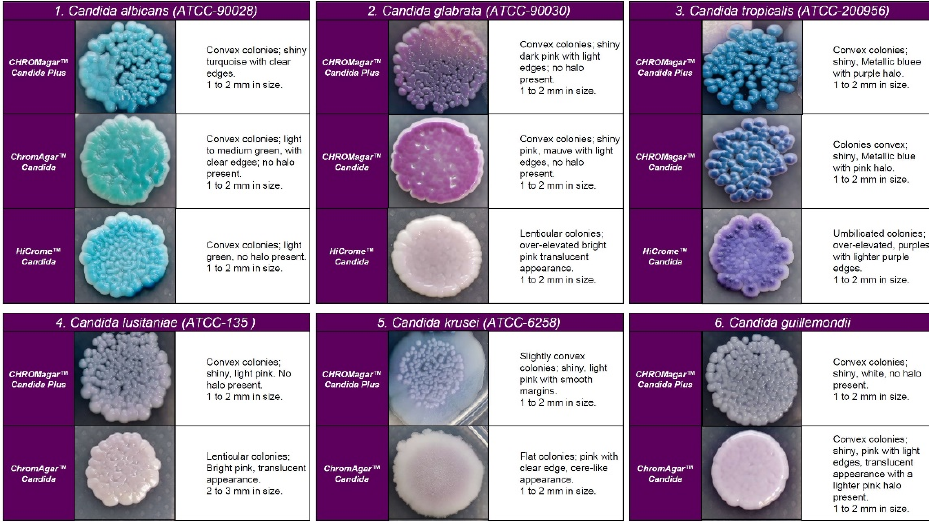
Figure 2. Appearance of colonies of most pathogenic Candida species on CHROMagar™ Candida Plus medium, CHROMagar™ Candida medium, and HiCrome TM Candida after 48 h incubation at 35 °C.